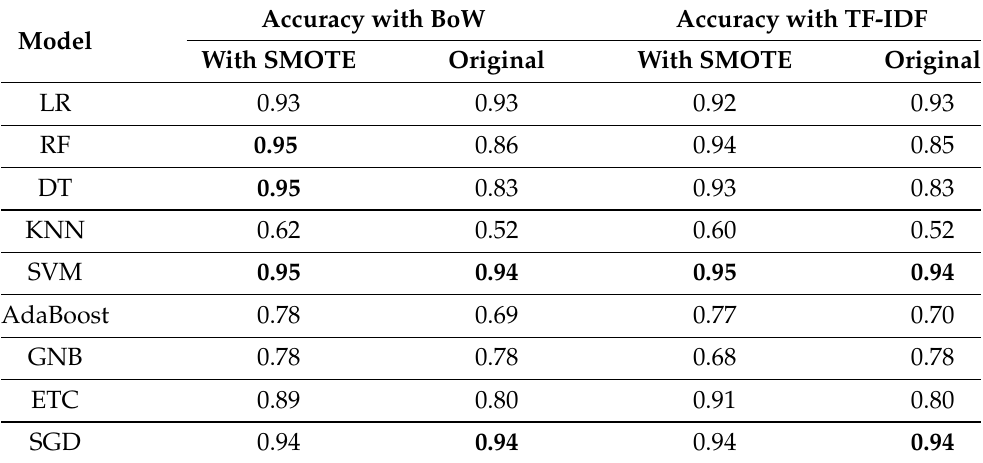
Table 14. Summary of models’ performance with BoW and TF-IDF. Model